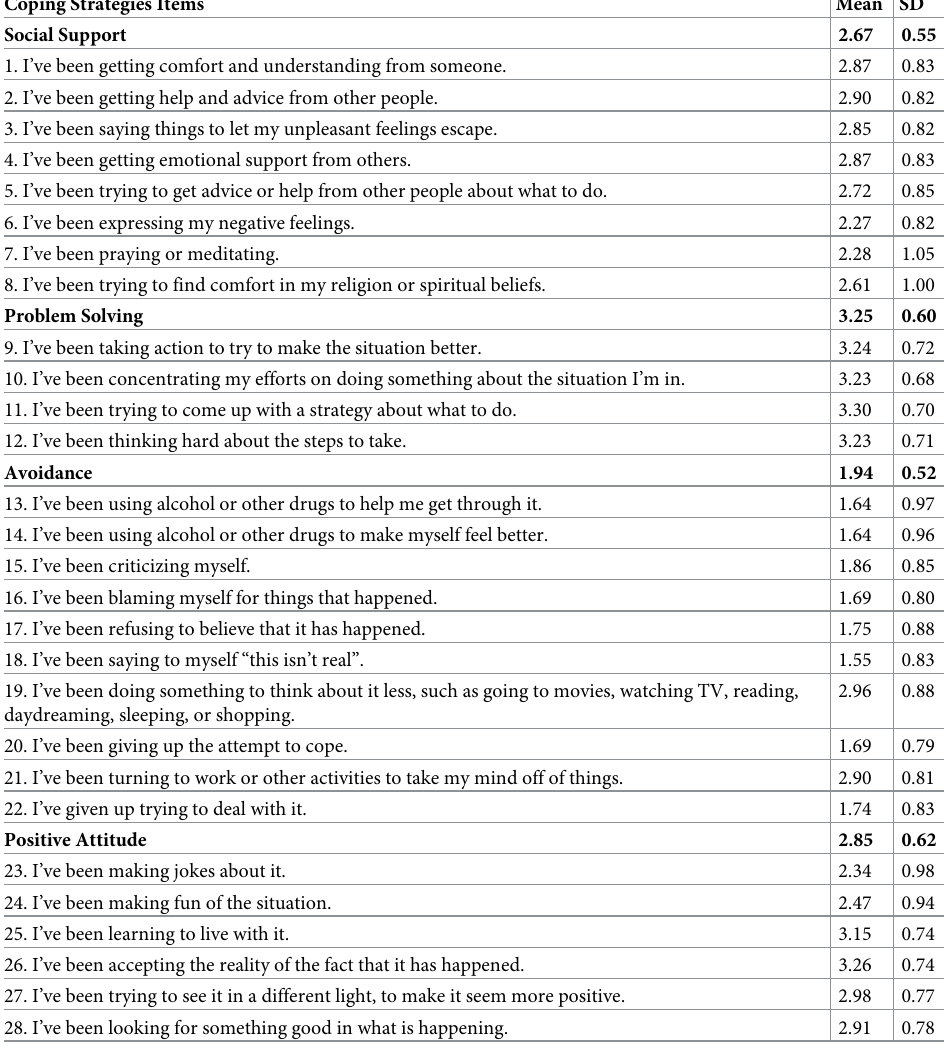
Table 2. Descriptive statistics of coping strategies (Brief-COPE score) by dimensions and